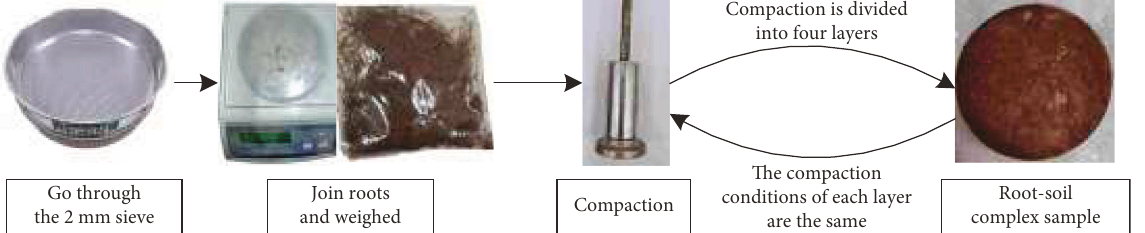
Figure 2: Sample production